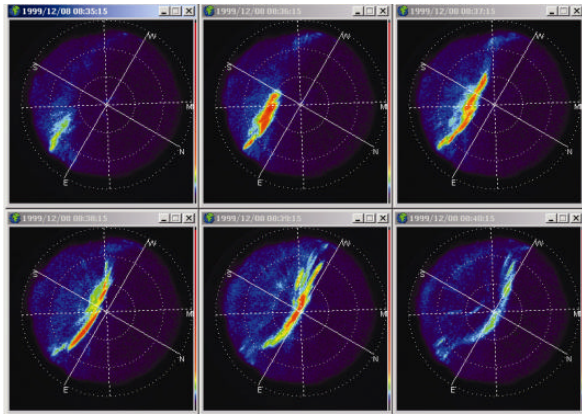
Figure 9 Fig. 9. ASC images at 557.7nm from Ny ˚Alesund, representing the times 08:35:15, 08:36:15, 08:37:15, 08:38:15, 08:39:15,